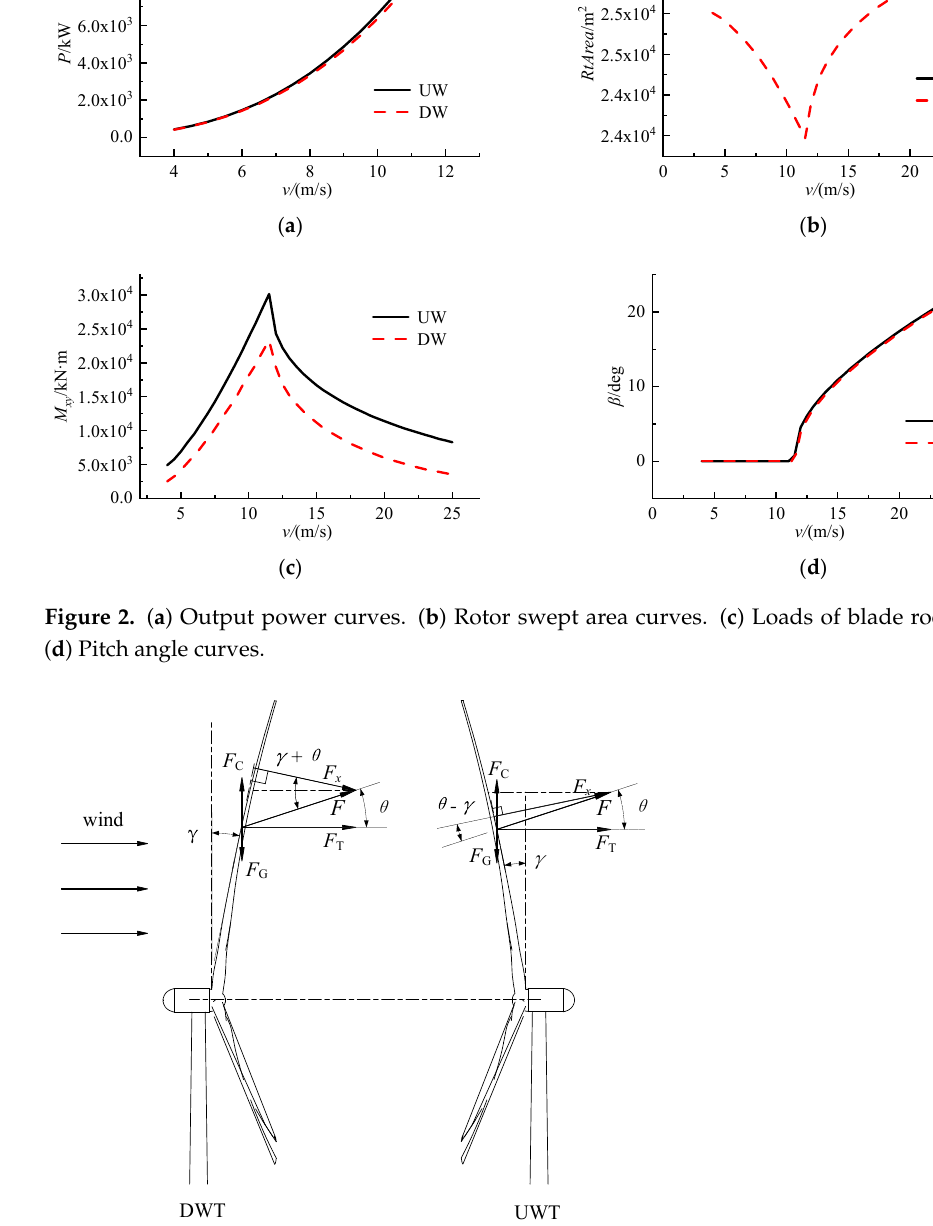
Figure 3. Influence of rotor cone angle on blade load.